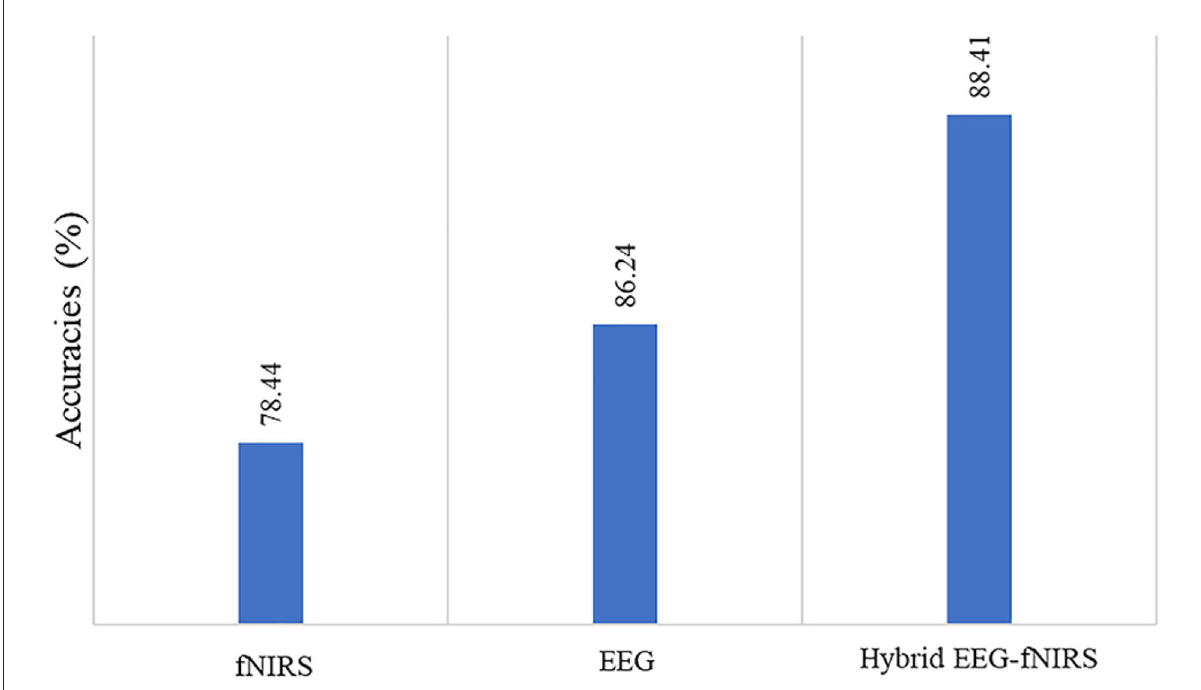
FIGURE8 Comparison of accuracies of fNIRS-based BCI, EEG-based BCI, and hybrid EEG-fNIRS-based BCI.